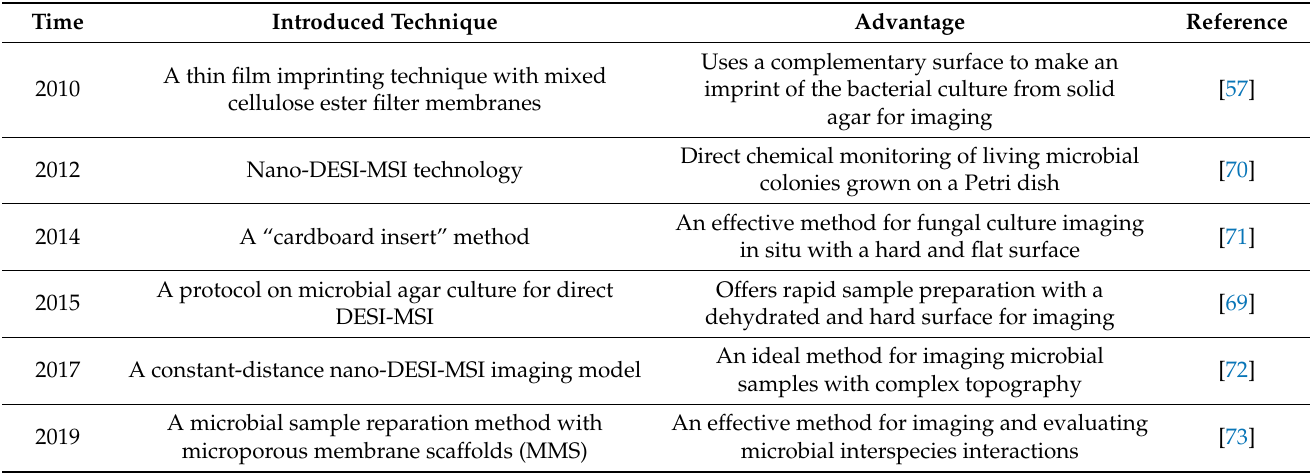
Table 3. Technical advances in sample preparation of microbial DESI-MSI.